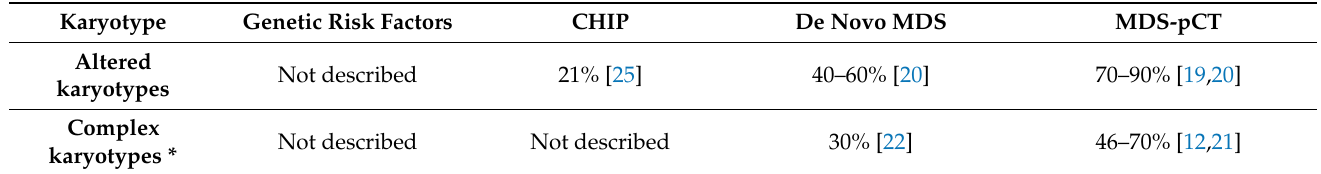
Table 1. Chromosome alterations associated with MDS with different